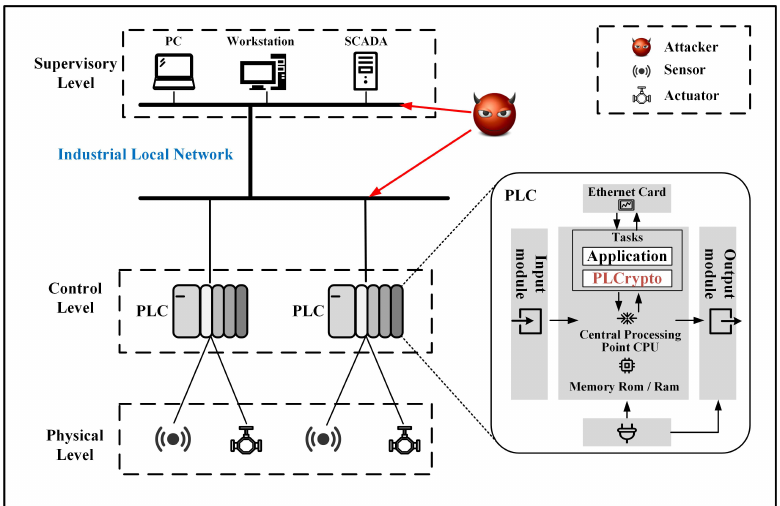
Figure 2: System Model of Industrial Control Systems. PLCs sit between the physical processes and supervisory level. Remote attackers are assumed to be able to get access to the operational technology